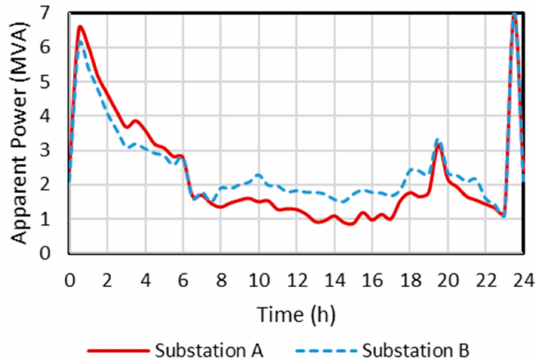
Figure 7. Apparent power flows through transformers after the introduction of DR scheme for scenario 2.